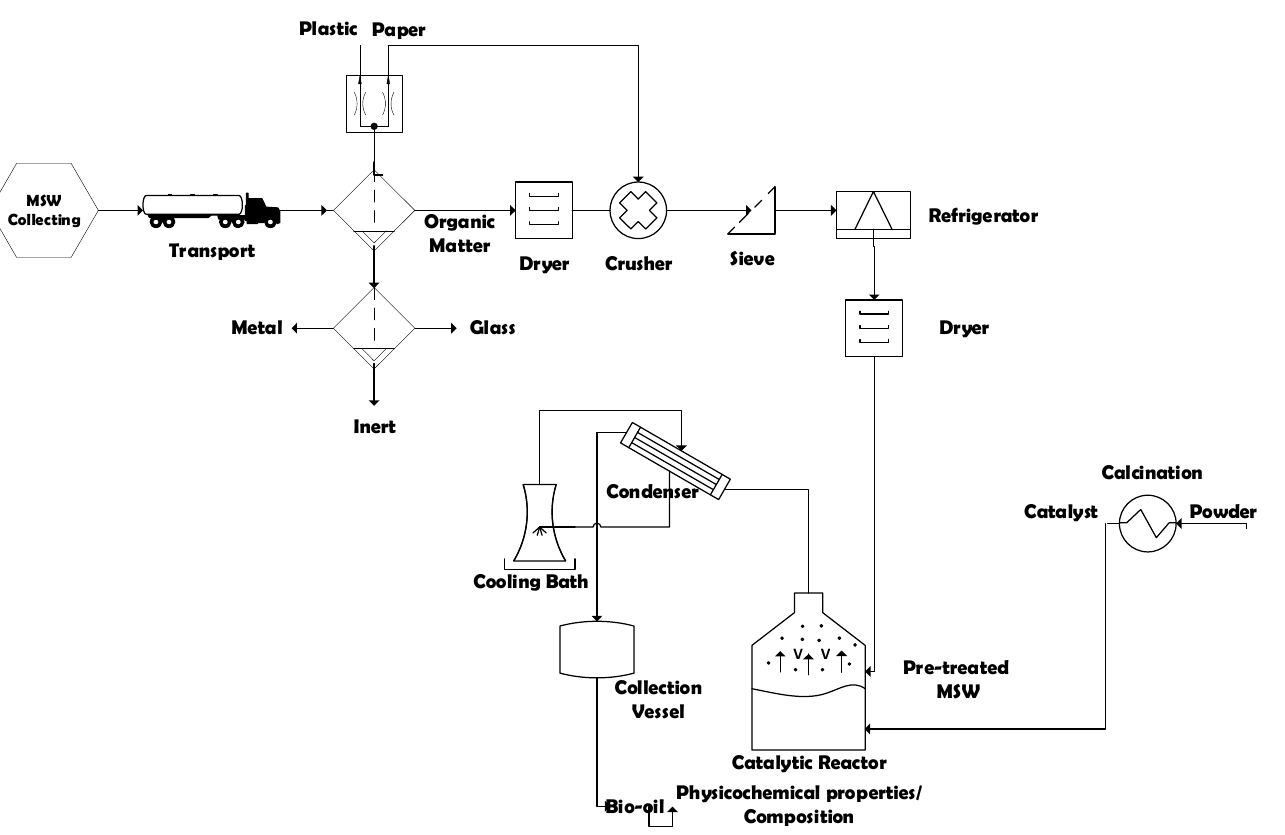
Figure 1. Process flowsheet by collecting, classification/segregation, and pre-treatment of MHSW and thermal processing of pre-treated (organic matter + paper) at 400, 450, and 475 °C, 1.0 atm, 0.0, 5.0, 10.0, and 15.0% (wt.) of Ca(OH) 2 , in laboratory scale.